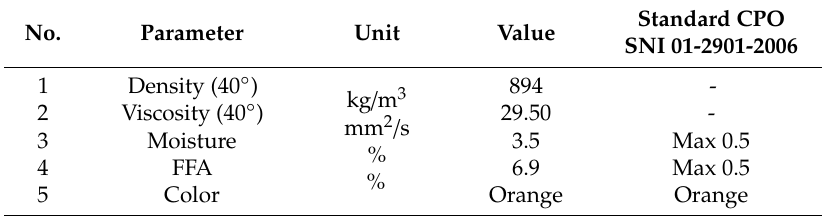
Table 1. Properties of crude palm oil o ff -grade. Legend: FFA, free fatty acid. No. Parameter Unit Value